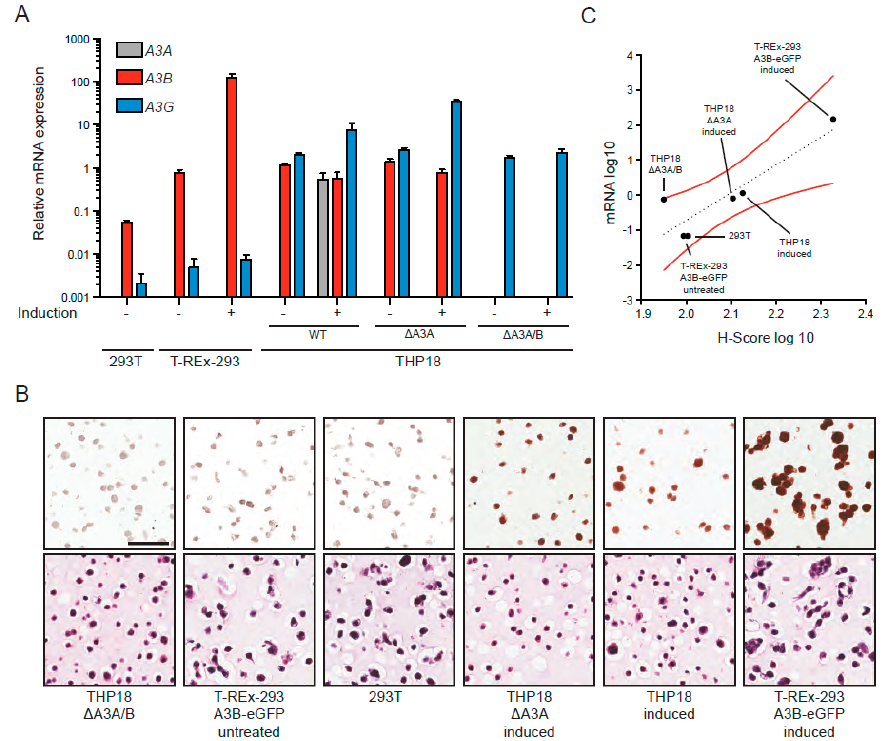
Figure 4. A3B mRNA levels correlate with IHC histo-score (H-score) using the 5210-87-13 mAb: ( A ) Assessment of A3A , A3B and A3G mRNA levels by RTqPCR in the indicated cell lines; ( B ) representative IHC images from 5210-87-13 staining of the indicated cell lines in the context of a cell microarray (CMA) (top row), along with corresponding hematoxylin photomicrographs (bottom row). Scale bar is 60 µ m; and ( C ) dot plot showing the positive correlations between A3B mRNA levels and IHC H-scores from 5210-87-13 mAb nuclear straining of the indicated cell lines (H-score; R 2 = 0.8, Pearson correlation coe ffi cient =